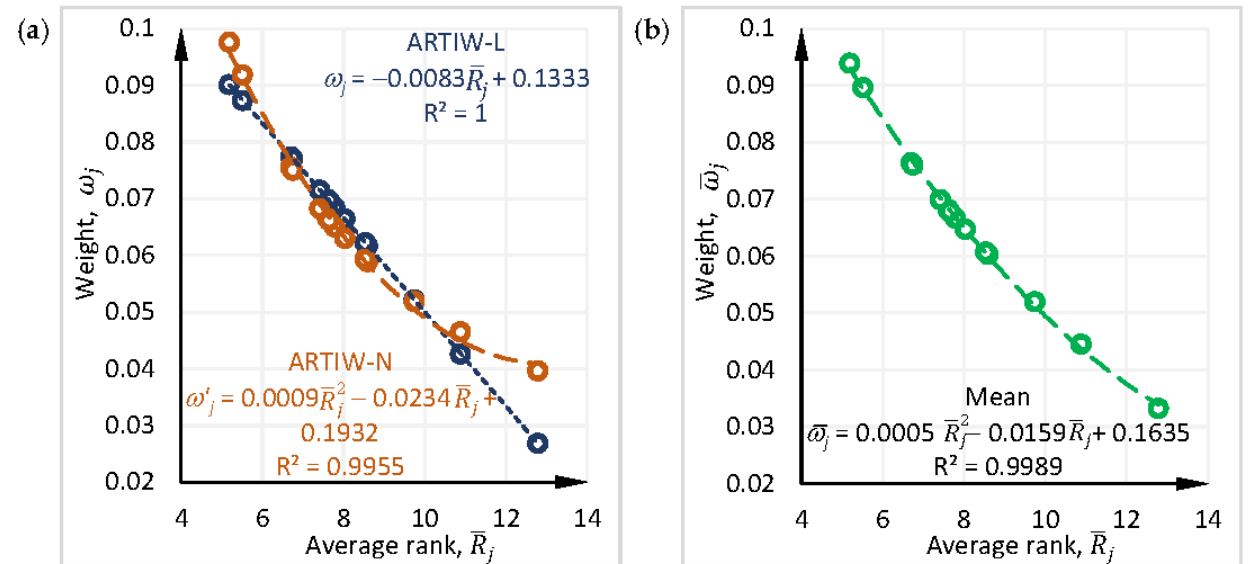
Figure 5. Correlation between the means of the sub-criteria ranks and the normalized weights of these sub-criteria calculated using: ( a )—ARTIW-L and ARTIW-N methods; ( b )—average values of two methods.